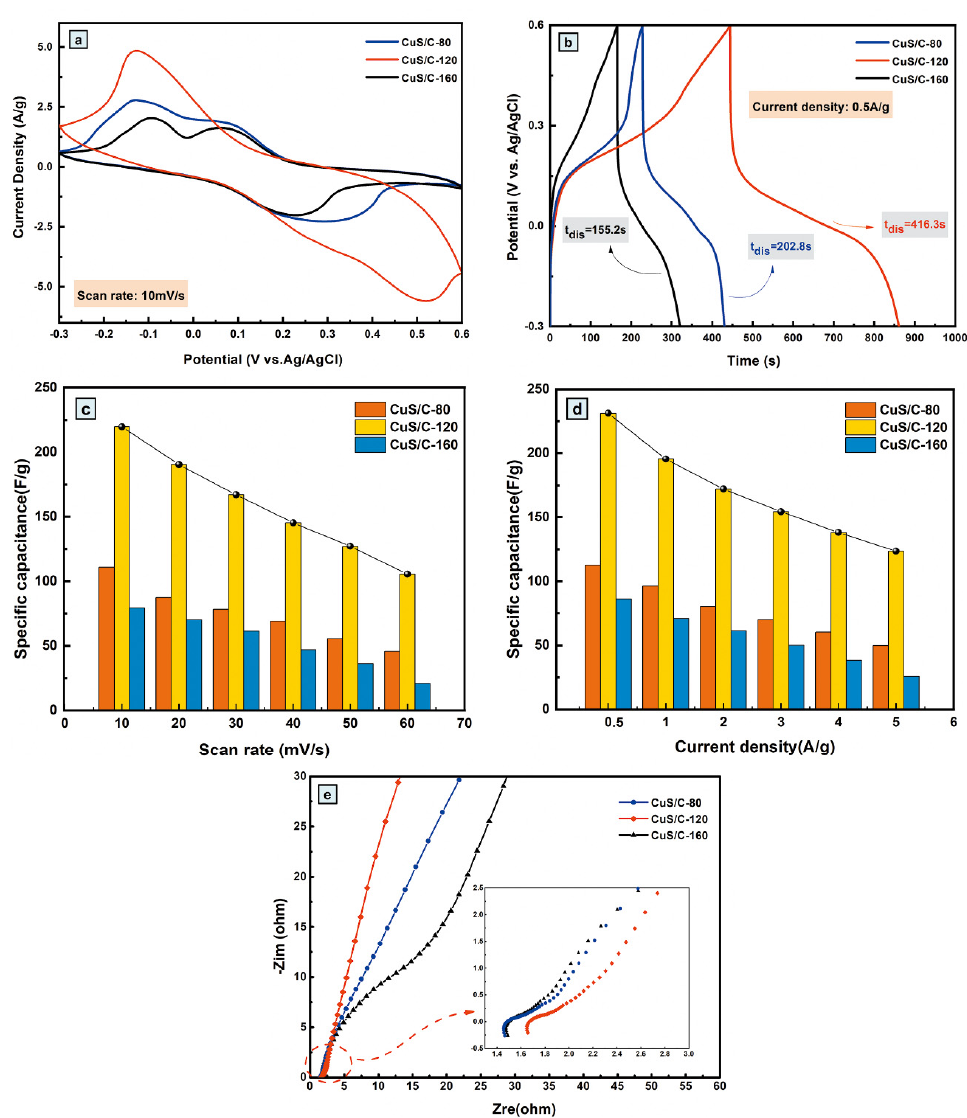
Figure 9. ( a ) Comparison cyclic voltammetry (CV) curves for CuS / C-80, CuS / C-120 and CuS / C-160 electrodes at 10 mV − 1 ; ( b ) Comparison charge-discharge curves for CuS / C-80, CuS / C-120, and CuS / C-160 electrodes at 0.5 Ag − 1 ; ( c ) The specific capacitance at di ff erent scan rates of CuS / C-80, CuS / C-120, and CuS / C-160 electrodes; ( d ) The specific capacitance at di ff erent current densities of CuS / C-80, CuS / C-120, and CuS / C-160 electrodes; ( e ) Nyquist electrochemical impedance spectra of CuS / C-80, CuS / C-120, and CuS / C-160 electrodes (inset: the enlarged high frequency